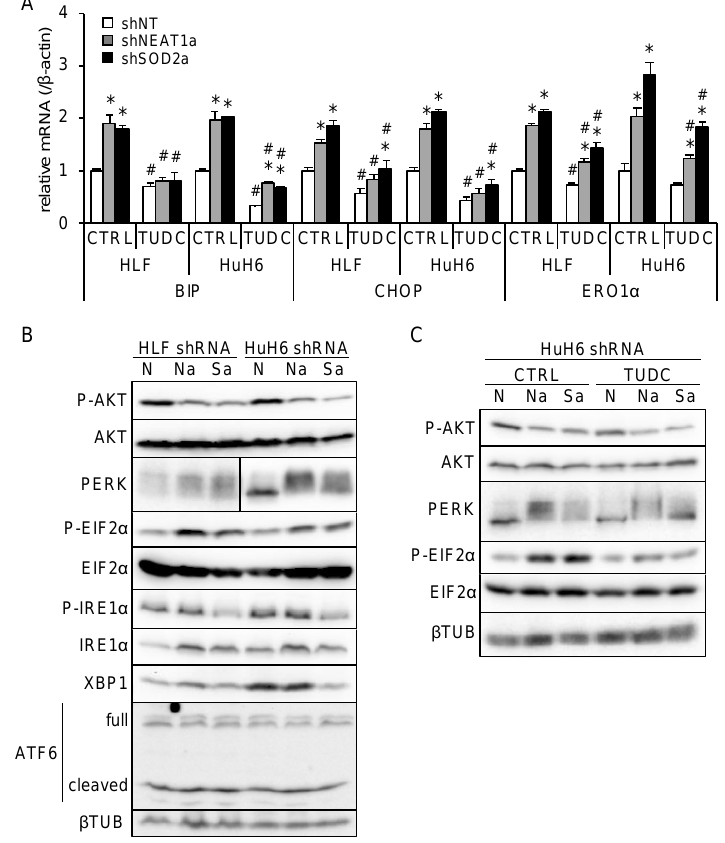
Figure 5. NEAT1v1 or SOD2 knockdown suppresses AKT activity independent of ER stress. ( A ) mRNA expression of ER stress target genes (BIP, CHOP, and ERO1 α ). HLF and HuH6